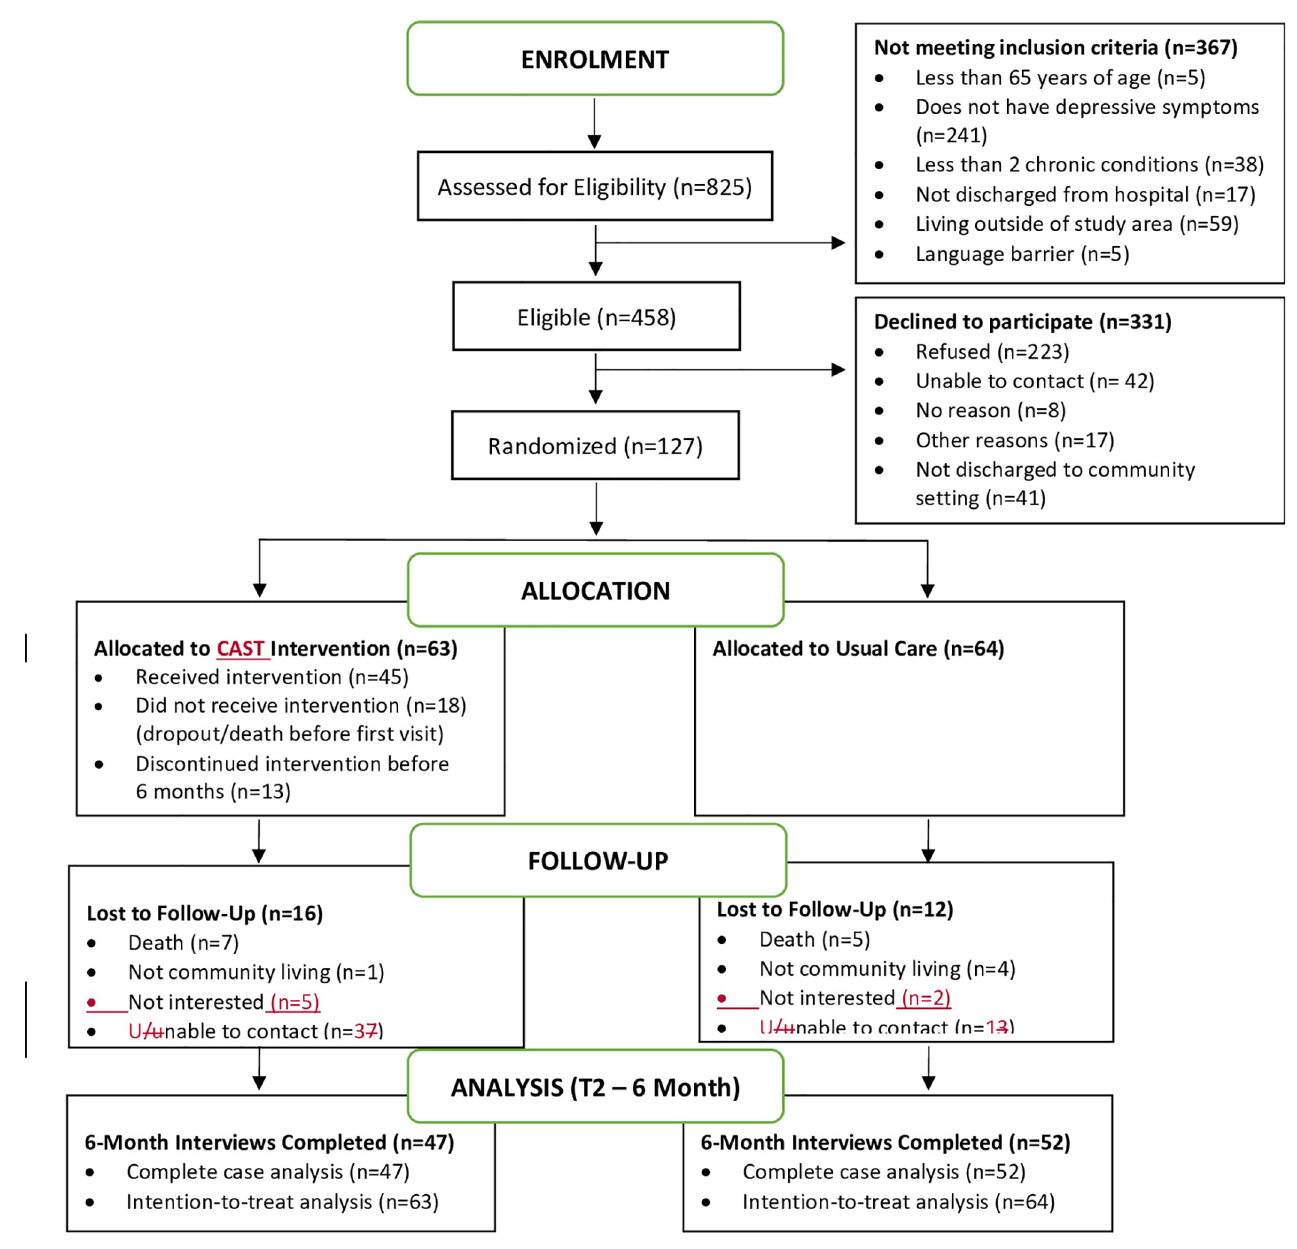
Fig 1. Study flow